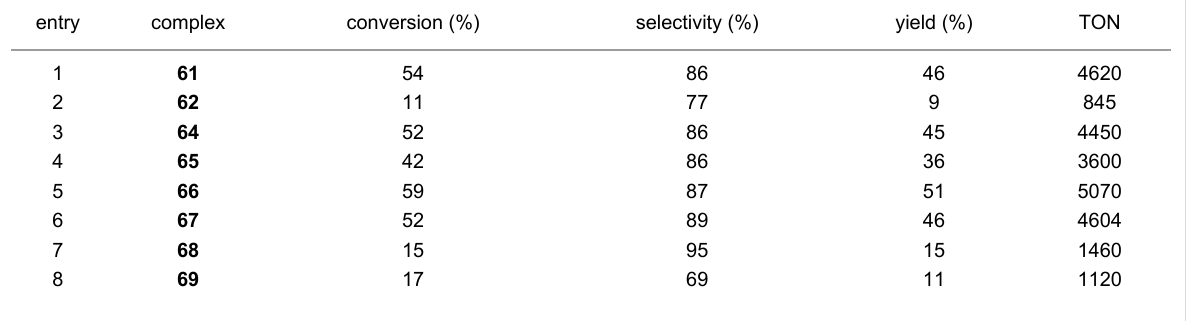
Table 2: Ethenolysis of methyl oleate ( 70 ) with catalysts 61 – 69